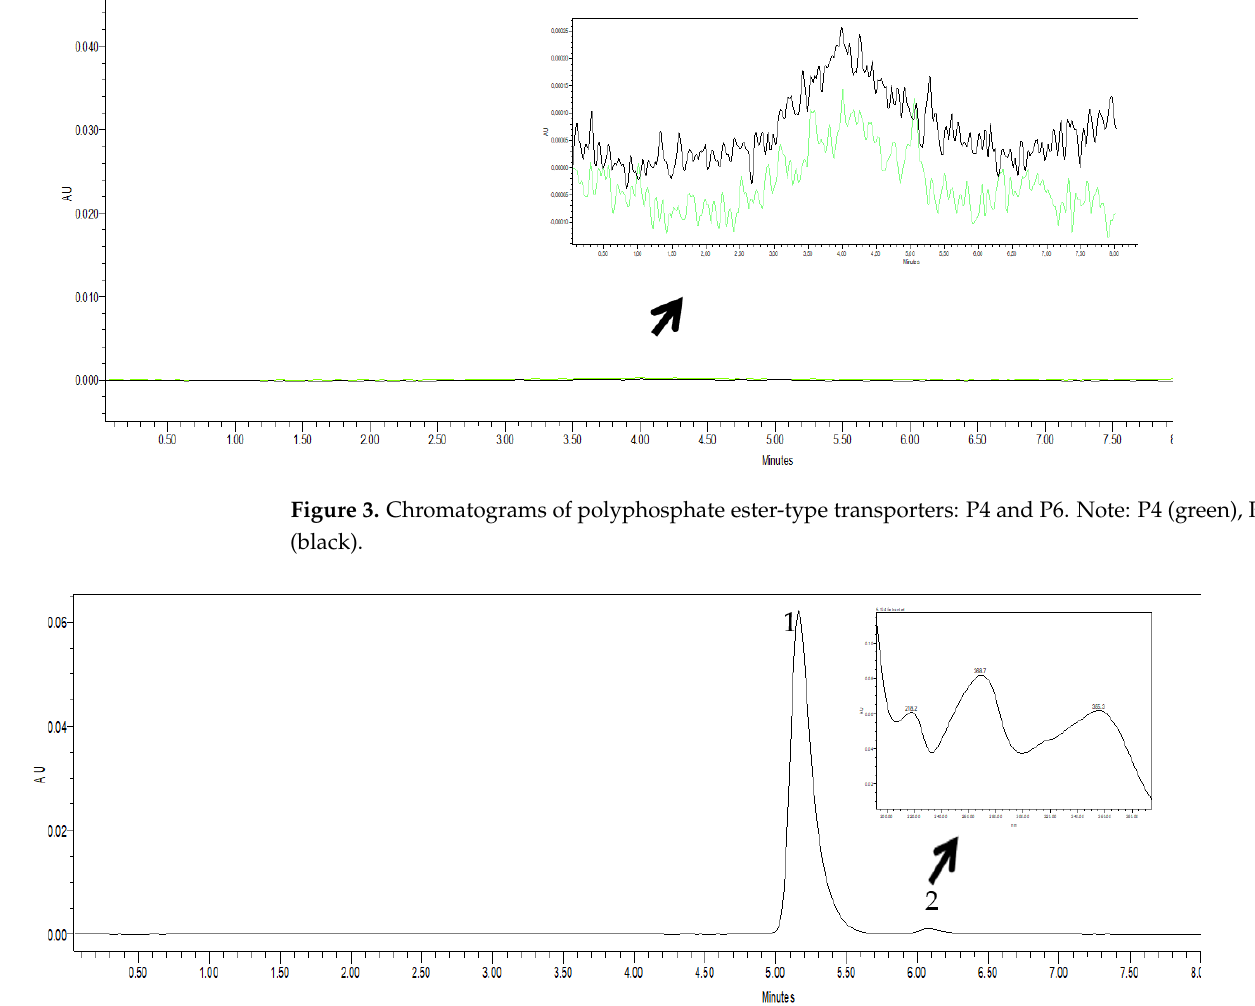
Figure 4. Chromatogram of a standard solution of oxytetracycline hydrochloride. * Note: in this and